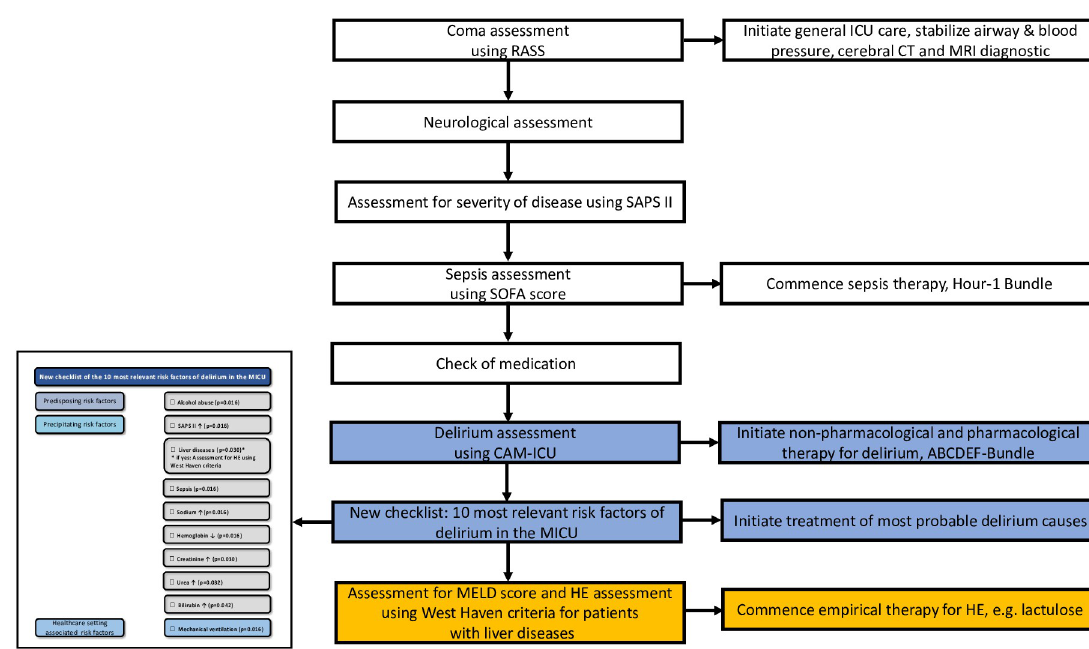
Fig 6. Proposed new algorithm for the diagnosis, characterization and treatment of altered mental status in the ICU.